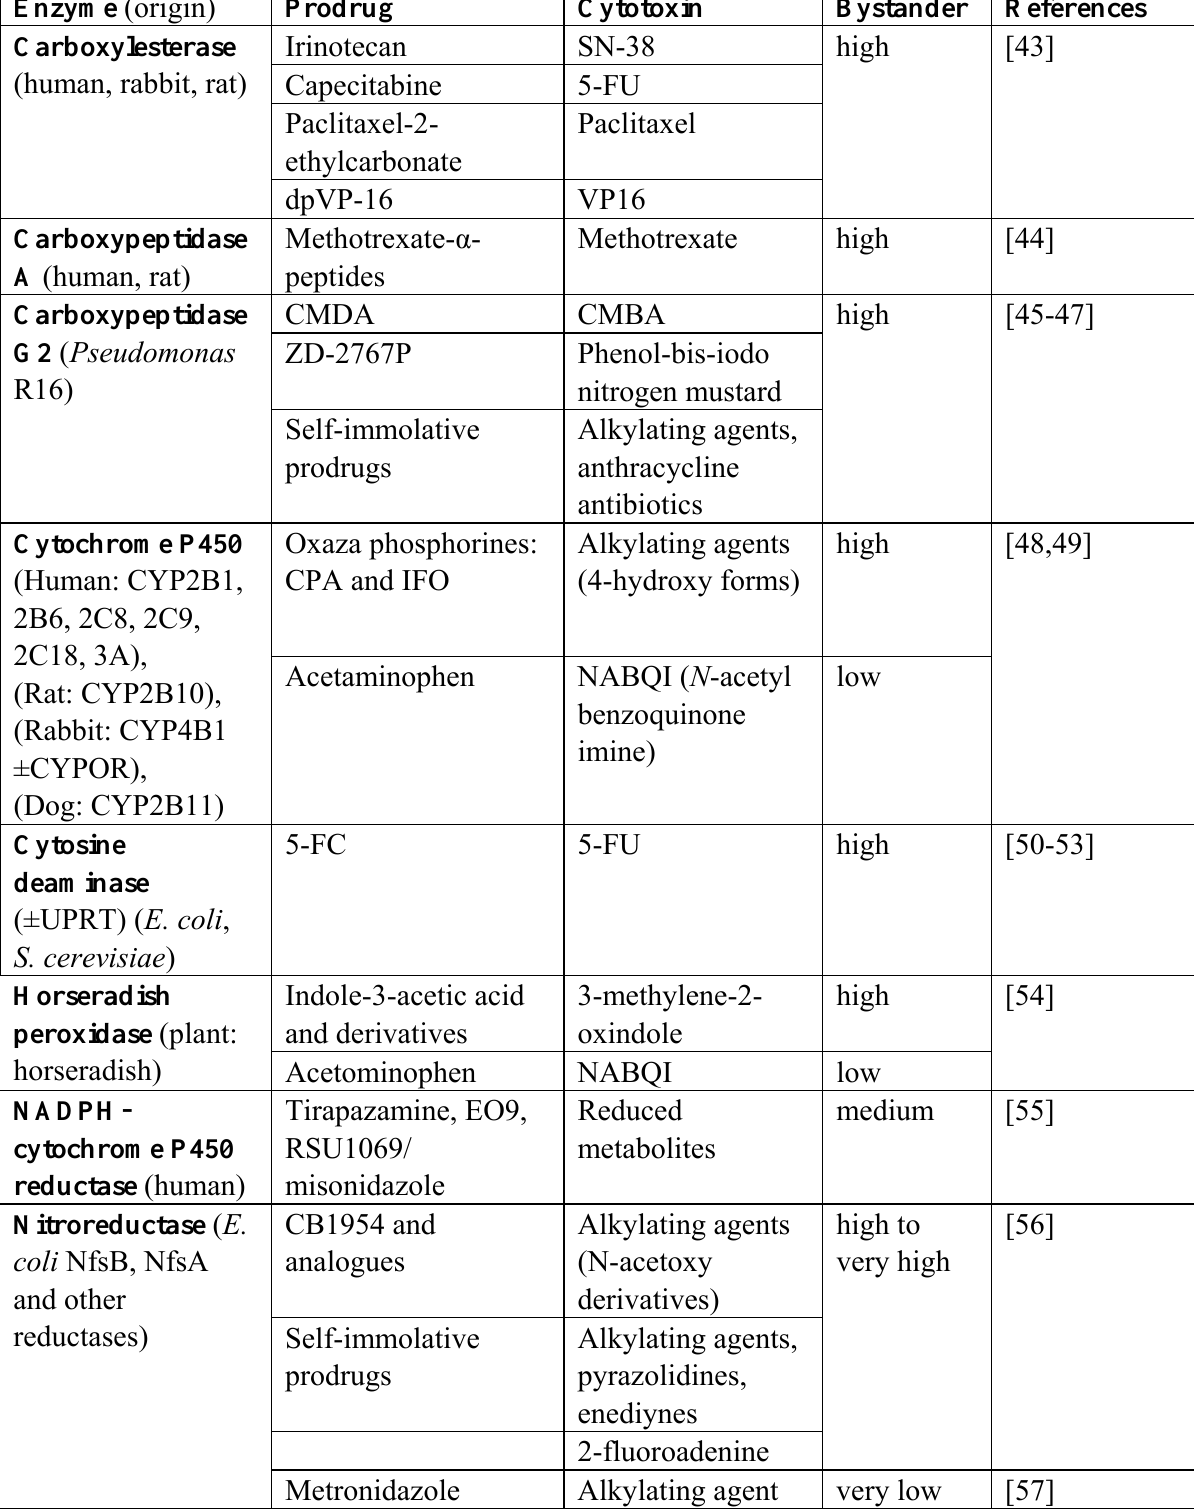
Table 1. Selected enzyme prodrug systems used in gene therapy (table adapted from